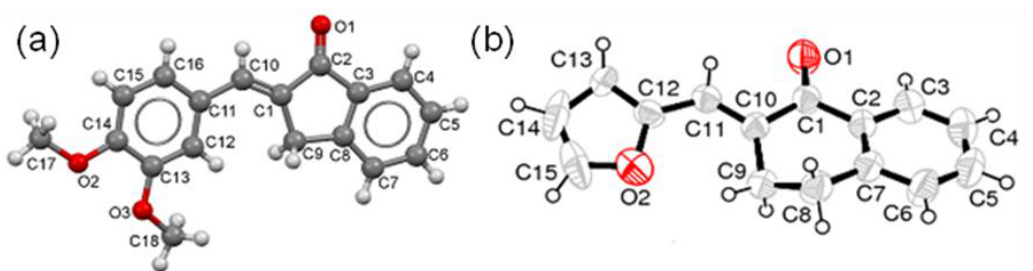
Figure 1. The ORTEP diagram of ( a ) 5g . ( b ) 5i .